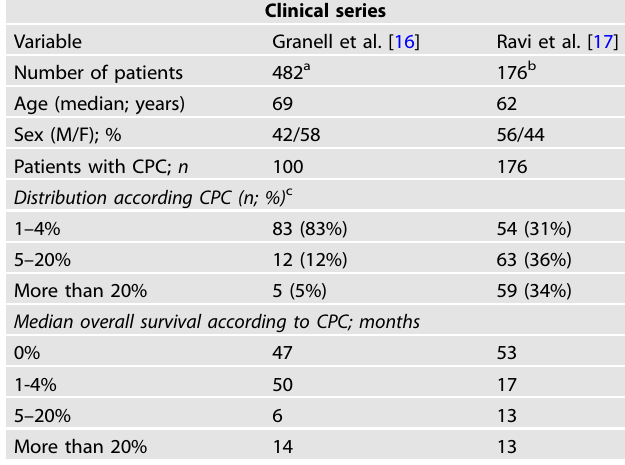
Table 1. Main results of the two clinical studies used for this position paper [16,